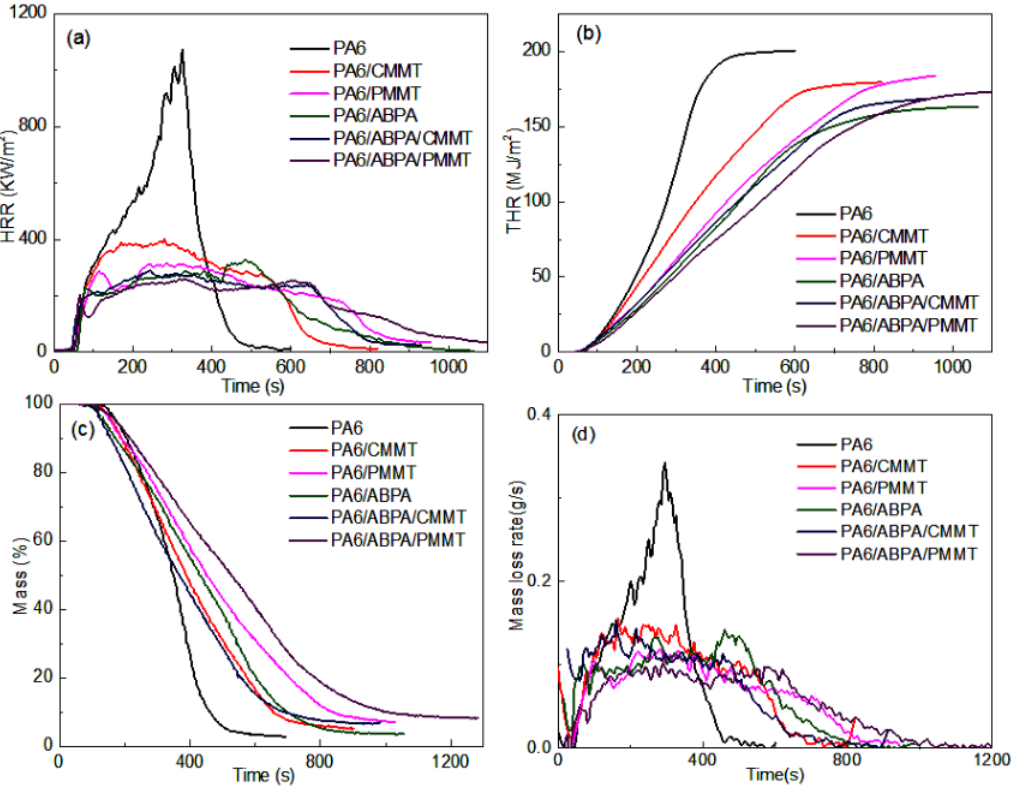
Figure 6. HRR curve ( a ); THR curve ( b ); mass loss curve ( c ) and mass loss rate (MLR) curve ( d ) for PA6 and flame retardant PA6 composites .